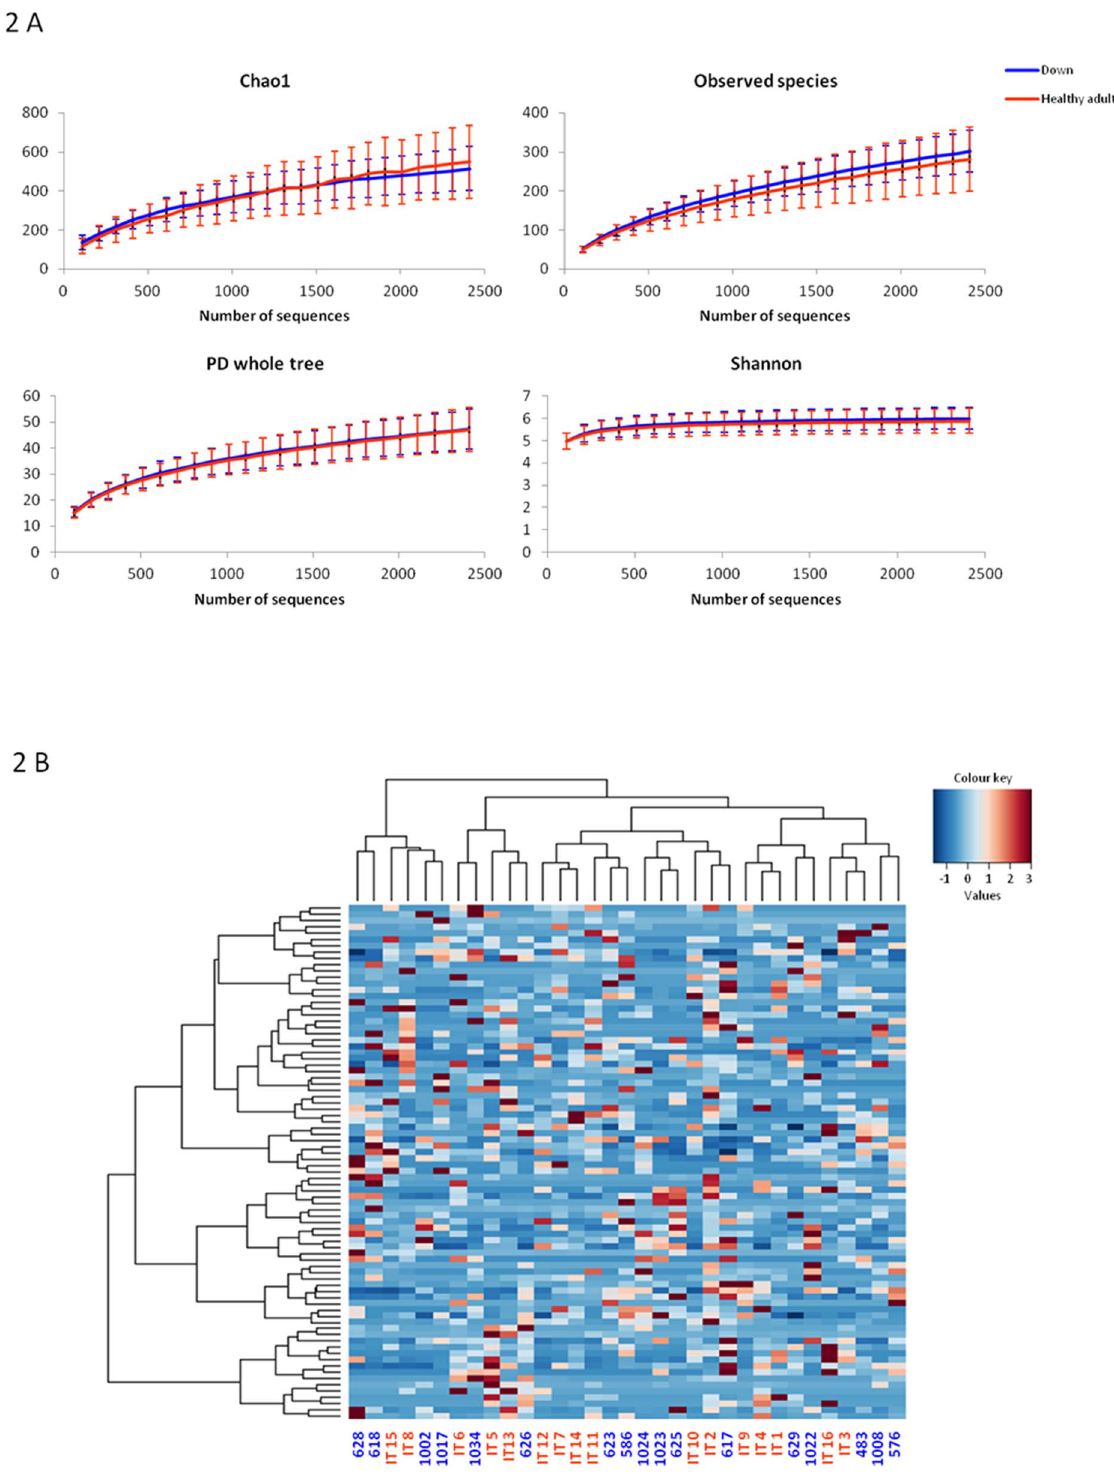
Figure 2. Similarity between the gut microbiota of DS persons and healthy non-trisomic adults for diversity and overall community composition. (A) Superimposition of the rarefaction curves of different a -diversity metrics (Faith’s phylogenetic diversity (PD whole tree), observed OTUs, the Chao1 measure of microbial richness, and the Shannon index of biodiversity). (B) Hierarchical Ward-linkage clustering based on the Spearman correlation coefficients of genus proportion, showing no separation between DS persons and healthy adults. Blue, DS persons; red, healthy adults [24].